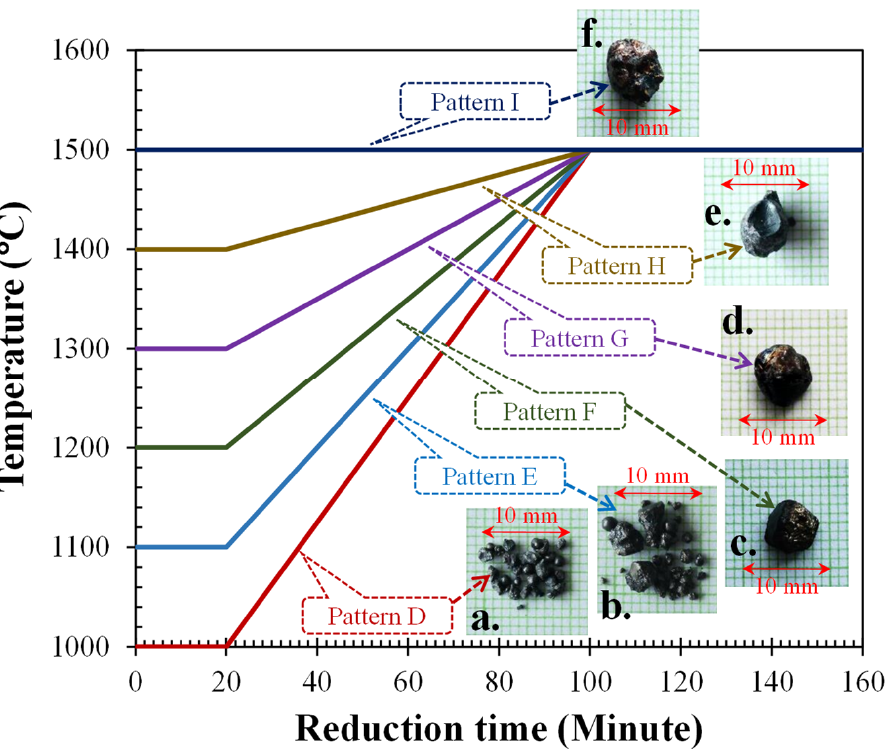
Figure 6. The temperature profile of ilmenite concentrate reduction by varying the initial temperature at 30% Na 2 CO 3 addition (( a – f ) are metal granules after separating from slag).